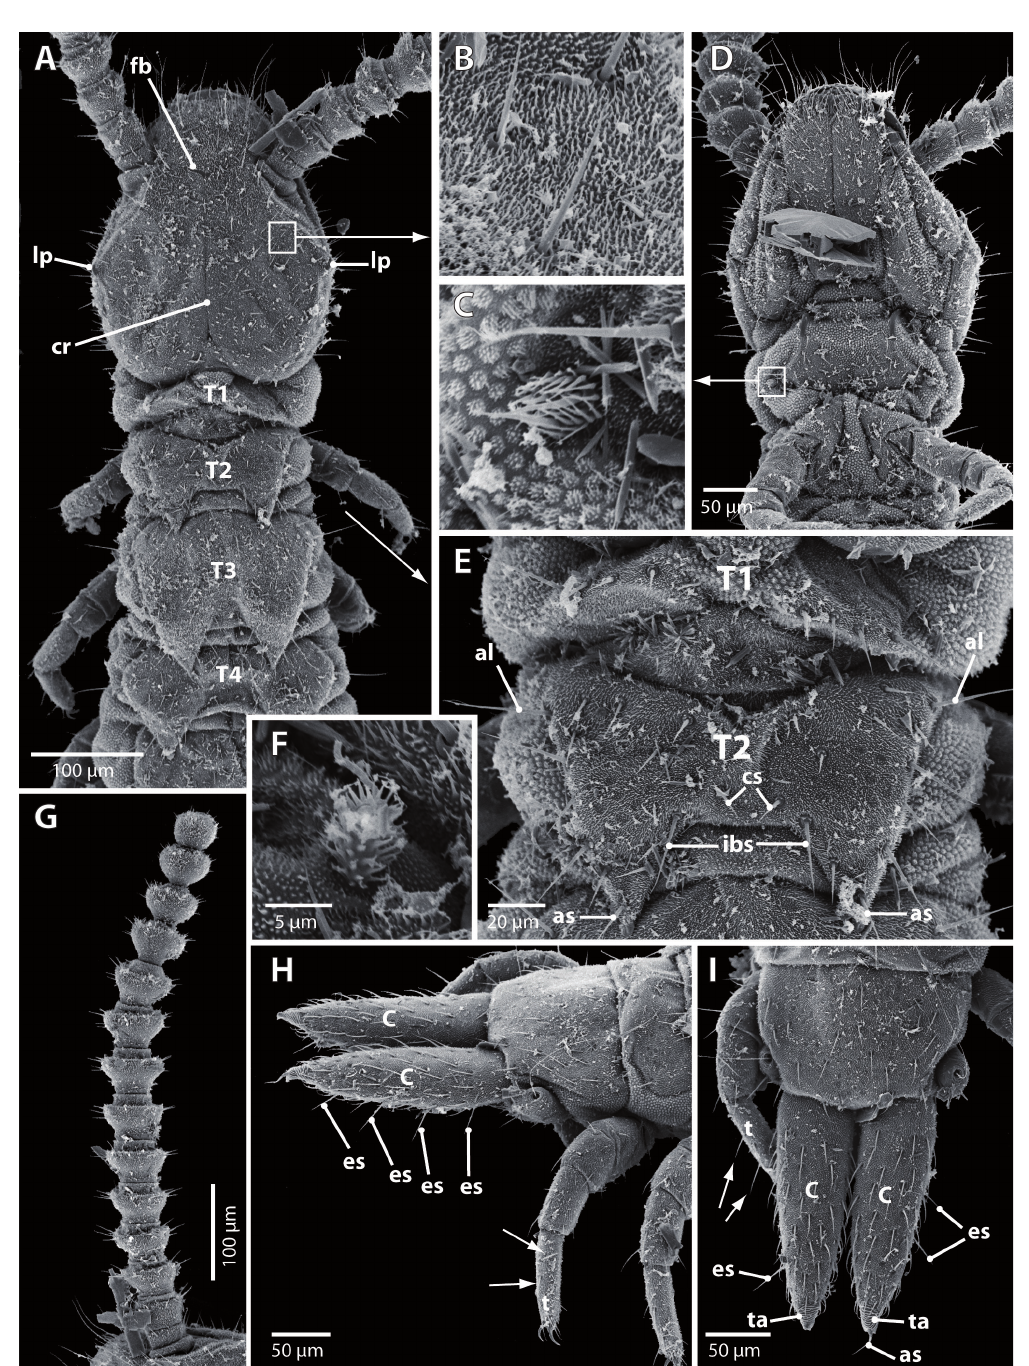
Fig. 1. Symphylella erecta sp. nov., holotype (dorsal and lateral views) and paratype MRAC 22149 (ventral view). A . Head and first 4 tergites ( T1, T2, T3, T4 ), dorsal view. Cr, central rod; fb, frontal branches; lp , lateral protuberances of head. B . Detail of the surface of head. C . Detail of first leg. D . Head and first 2 pairs of legs, ventral view. E . Detail of first ( T1 ) and second tergites ( T2 ). Al , anterolateral setae; as , apical setae; cs, central setae of the posteromarginal setae; ibs , inner basal setae of the posteromarginal setae. F . Stylus of leg 10. G . Right antenna. H . Posterior part of trunk, last pair of legs ( t , tarsus) and cerci ( C ), lateral view. Arrows: erect setae of tarsus, es , ventral erect setae of cercus. I . Posterior part of trunk, last left leg and cerci ( C ), dorsal view. Arrows : two erect setae of tarsus ( t ) of the last left leg; as , apical seta; es , erect setae of the outer side of the cerci; ta , terminal